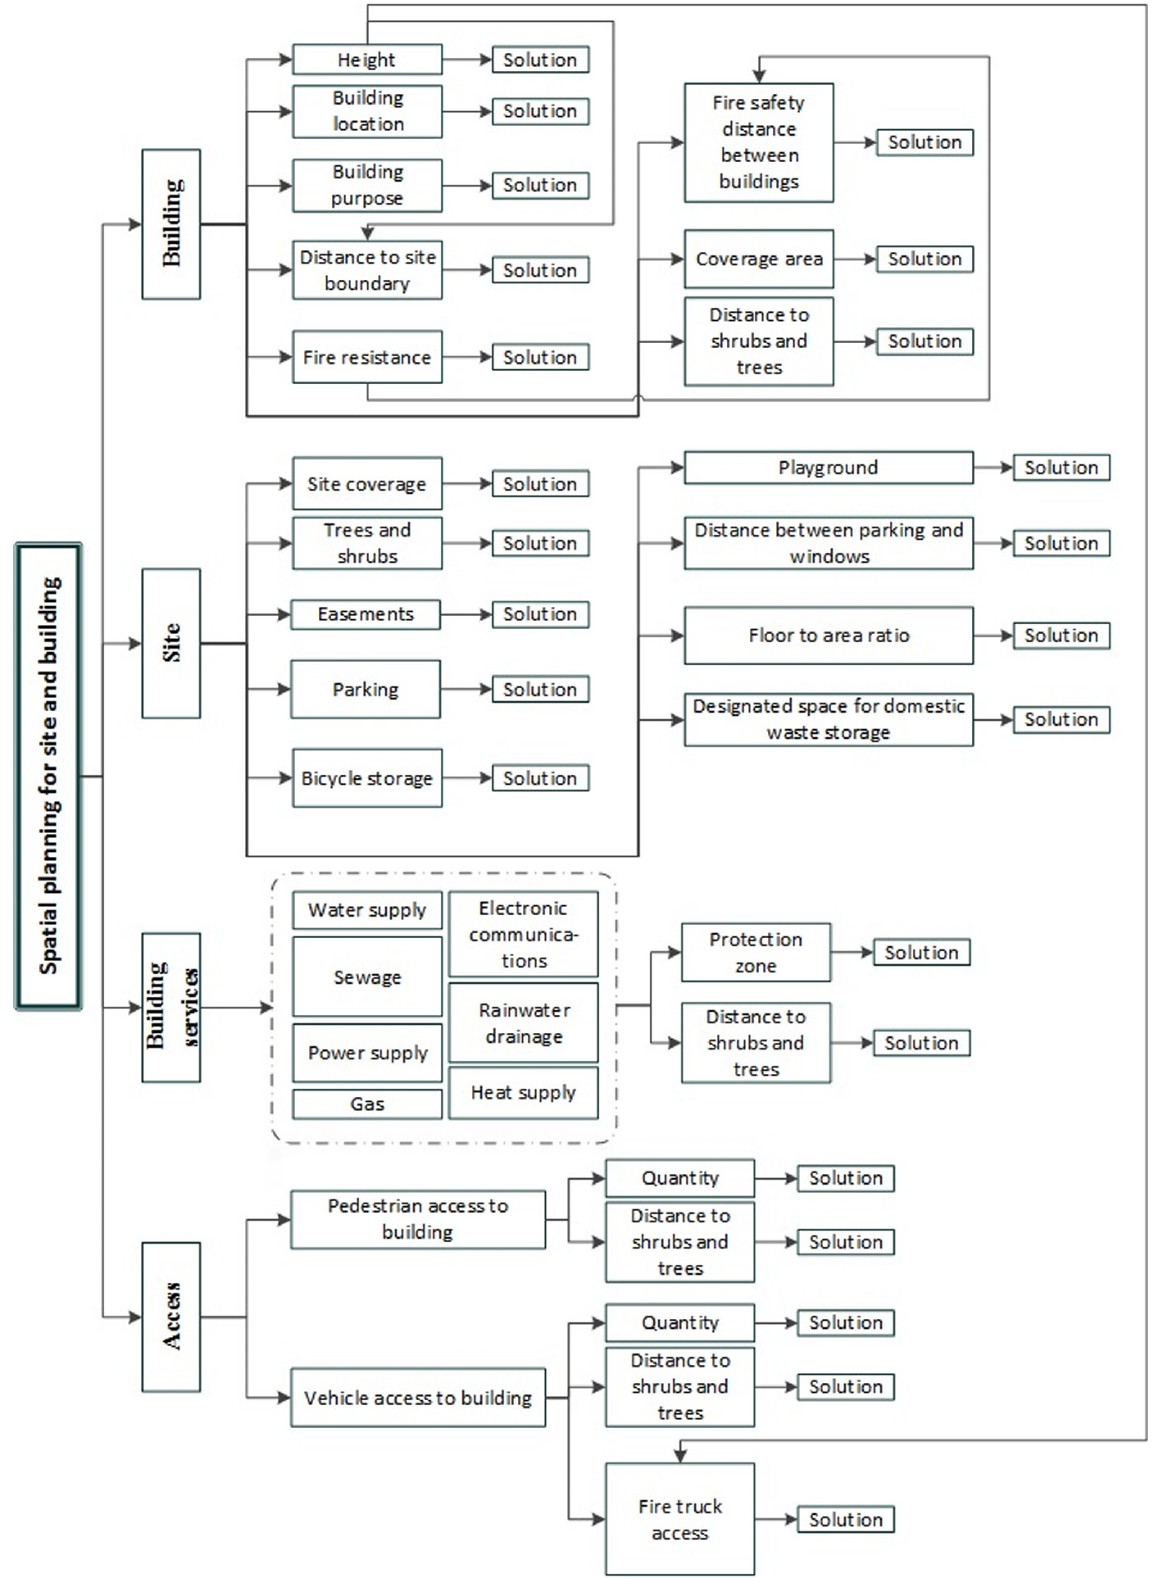
Fig. 3. Model for spatial site and building planning (diagram of